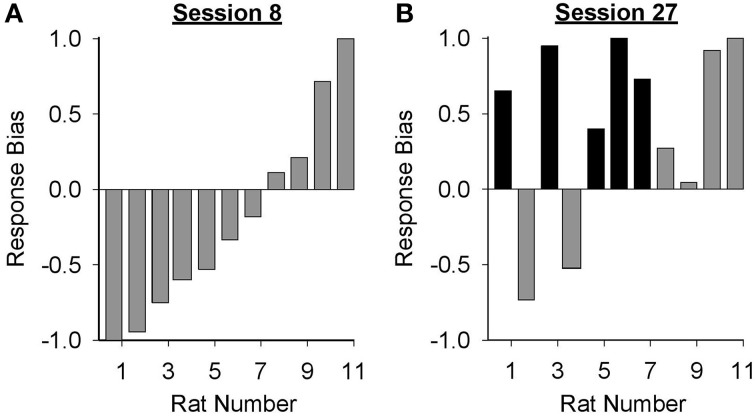
Response bias shifted from primarily goal-tracking to predominantly sign-tracking with extended Pavlovian autoshaping training. Response bias was calculated for each subject in the paired group using the formula: (number of lever-CS activations minus number of port entries)/(sum of lever-CS activations and port entries). The x-axis represents the identification number of individual rats represented in (A) session 8 and (B) session 27. A response bias score between −1 and 0 indicates a preference toward goal-tracking and a response bias score between 0 and 1 indicates a preference toward sign-tracking. Individual rats that demonstrated a shift in preference from goal-tracking in session 8 to sign-tracking in session 27 are depicted with black bars.